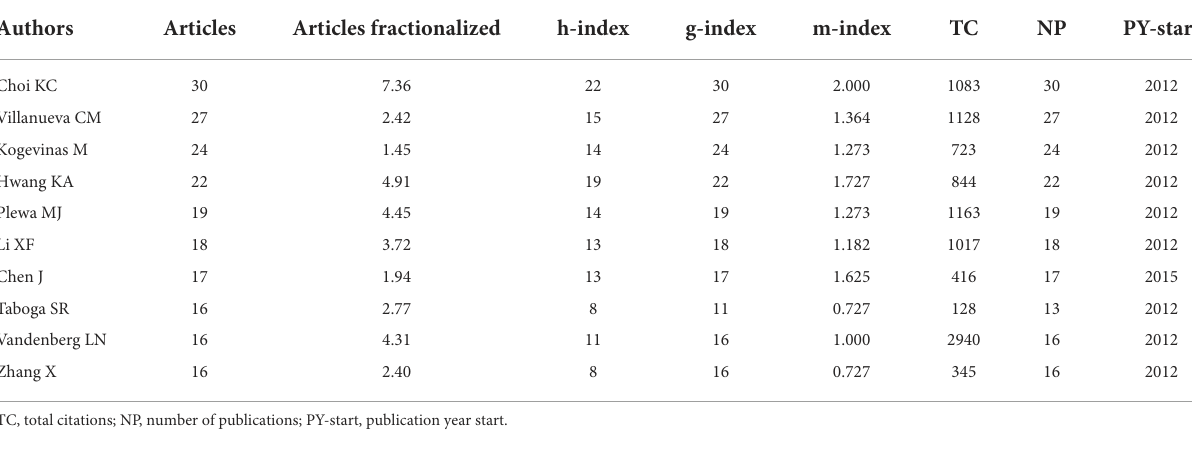
TABLE 6 Top 10 contributing authors in the field of ECs and cancer.